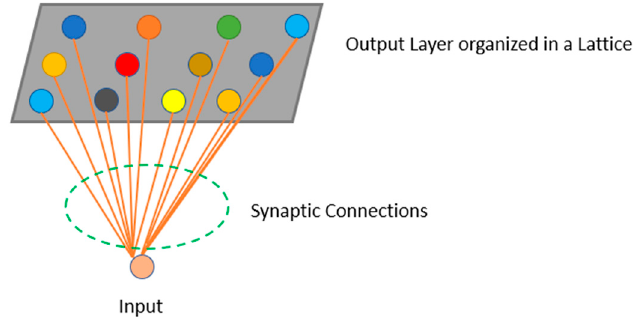
Figure 8. Kohnen model of self-organizing maps (SOM) neural network in the present